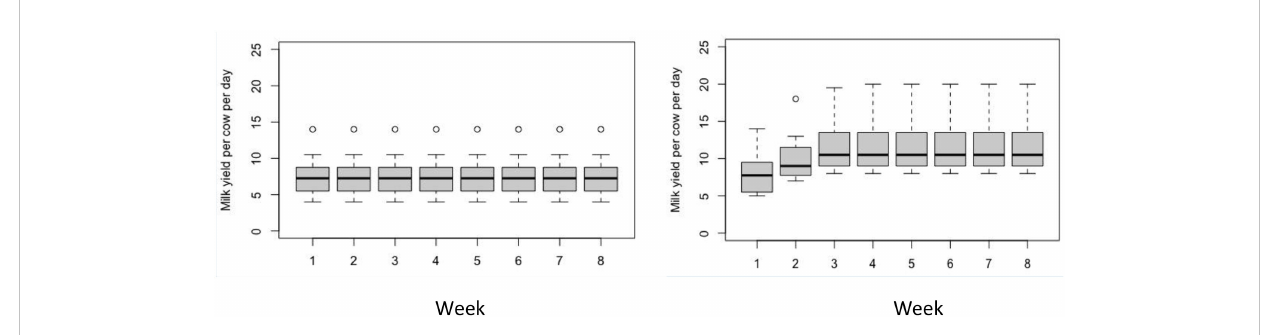
FIGURE 3 Comparison of effects of traditional feeding practice (left) and intervention diets (right) on milk yield (liter/cow/day).